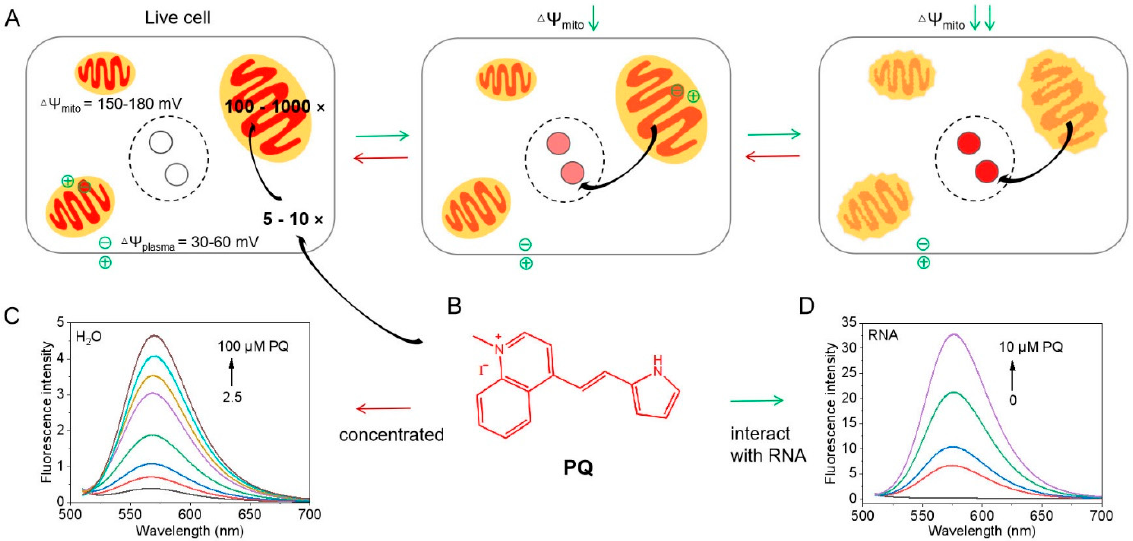
Figure 1. Principle of the reversibly migratable fluorescent probe PQ for the evaluation of MMP. ( A , B ) Schematic illustration of PQ migration between mitochondria and nucleolus and the chemical structure of PQ ; ( C ) fluorescence spectra of PQ for increasing concentrations (2.5, 5, 10, 20, 40, 60, 80, 100 µM from bottom to top) in aqueous solution mimicking high concentrations in mitochondria with high MMP; ( D ) the fluorescence spectra of PQ at relatively low concentrations (0, 1, 2.5, 5, 10 µM from bottom to top) in 0.5 mM yeast RNA, mimicking the interaction between PQ and RNA in nucleolus under decreasing MMP.